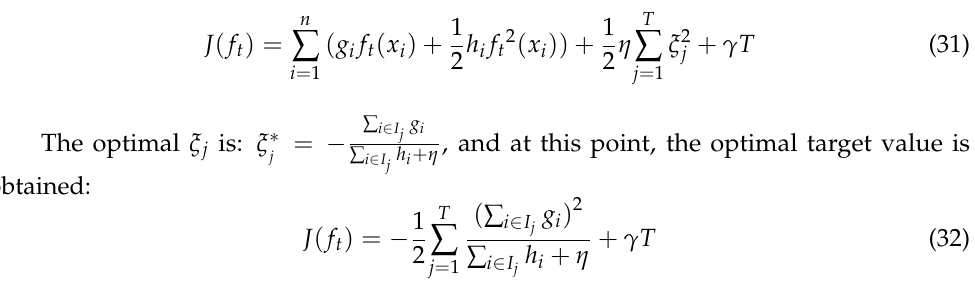
Figure 5. Actual sensor node installation and data collection diagram: ( a ) deployment of AE nodes and ( b ) display interface of AE data. 2.7.1. Time Series Decomposition of AE Waveform Signal Based on ACMD Here, we compare the wave decomposition effectiveness of ACMD and VMD [27]. A total of 90,000 sample points for a consecutive 9 s were selected from the training data, and VMD and ACMD were used for decomposition, as shown in the decomposition dia- gram below. The ordinate represents the amplitude of the sub-sequence after the original amplitude decomposition of each sampling point.